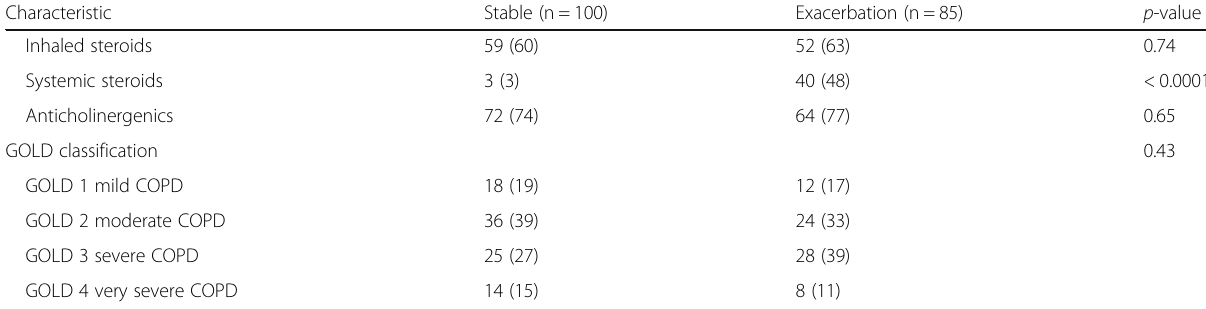
Table 2 Baseline Demographic and Clinical Characteristics of Enrolled Patients (Continued)